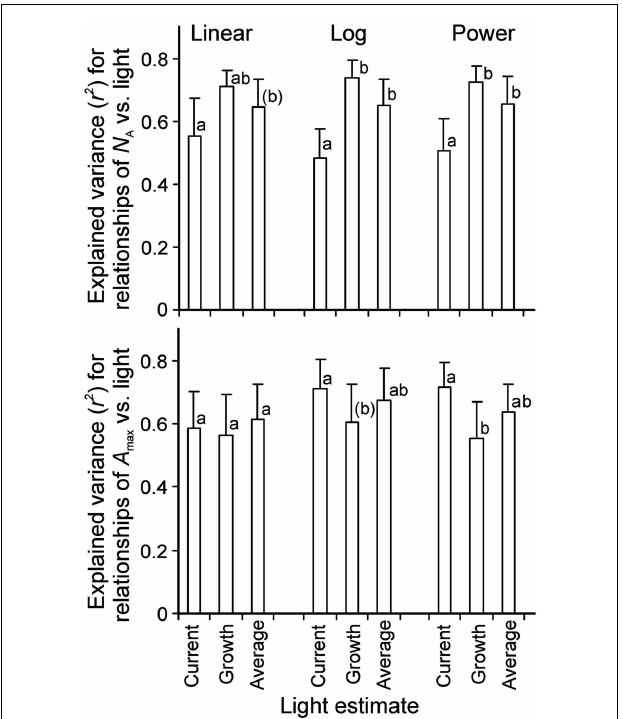
FIGURE 5 |Average ( + SE) explained variance of relationships of nitrogen content pear area ( N A , n = 7) and photosynthetic capacity ( A max , n = 6) vs. integrated quantum flux density ( Q int ) within the canopy. The integrated light used in the data fitting was either Q int at the time of measurements (current, Q int,C ), during growth ( Q int,G ), or the average during foliage lifetime until sampling (typically average of Q int,C and Q int,G ), and the data were either fitted by linear or non-linear regressions in the form of y = a Ln( x ) + b (Log) or y = ax b (Power). Figure 4 demonstrates sample relationships of N A vs. Q int fitted by y = a Ln( x ) + b .The r 2 data were compared by paired samples t -tests and different letters denote statistically significant differences among average r 2 values within given type of regression at P < 0.05, except for letters in parentheses that denote differences at P < 0.1. Only studies with completely artificial light in growth chambers (Pons et al., 1993; Lötscher et al., 2003) or with partial supply of artificial light in greenhouses (Pons et al., 1993; Xu et al., 1997; Dreccer et al., 2000; Pettersen et al., 2010;Trouwborst et al., 2010) were included in the analyses.The species available in these studies were grasses Brachypodium pinnatum (Pons et al., 1993), Carex acutiformis (Pons et al., 1993), Dactylis glomerata (Lötscher et al., 2003), and herbs Lycopersicon esculentum (Xu et al., 1997), Medicago sativa (Lötscher et al., 2003), Taraxacum officinale (Lötscher et al., 2003), and Cucumis sativus (Pettersen et al., 2010;Trouwborst et al., 2010; Table 1 for further information of data